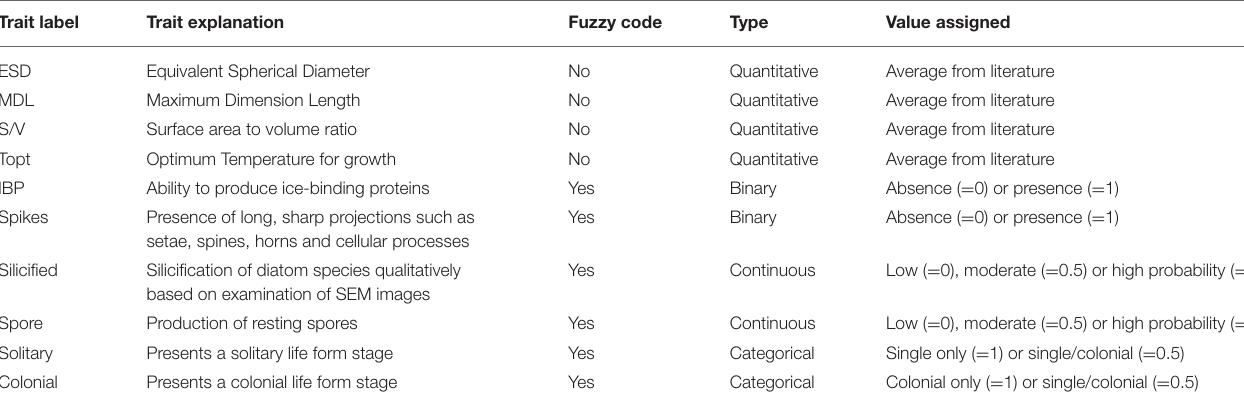
TABLE 1 | List of traits used in this study, in addition to the label, type and values assigned, and whether they were based or not on fuzzy code. Trait label